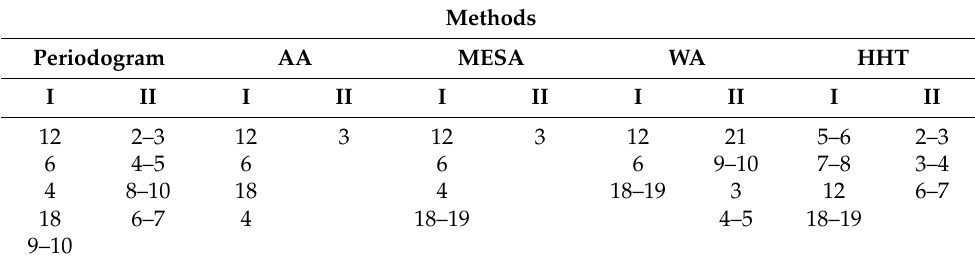
Table 7. The periods identified from monthly series at Huayuankou station.